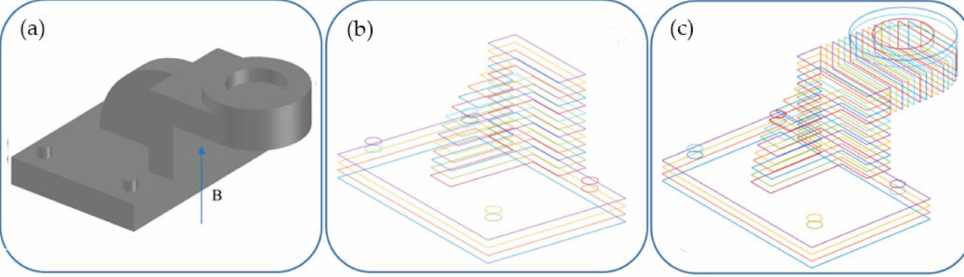
Figure 5. Parabola Mode: ( a ) Build direction model, ( b ) Buildable sub-volume without overhang & ( c ) complete 3D model. Reprinted from Ref. [13].